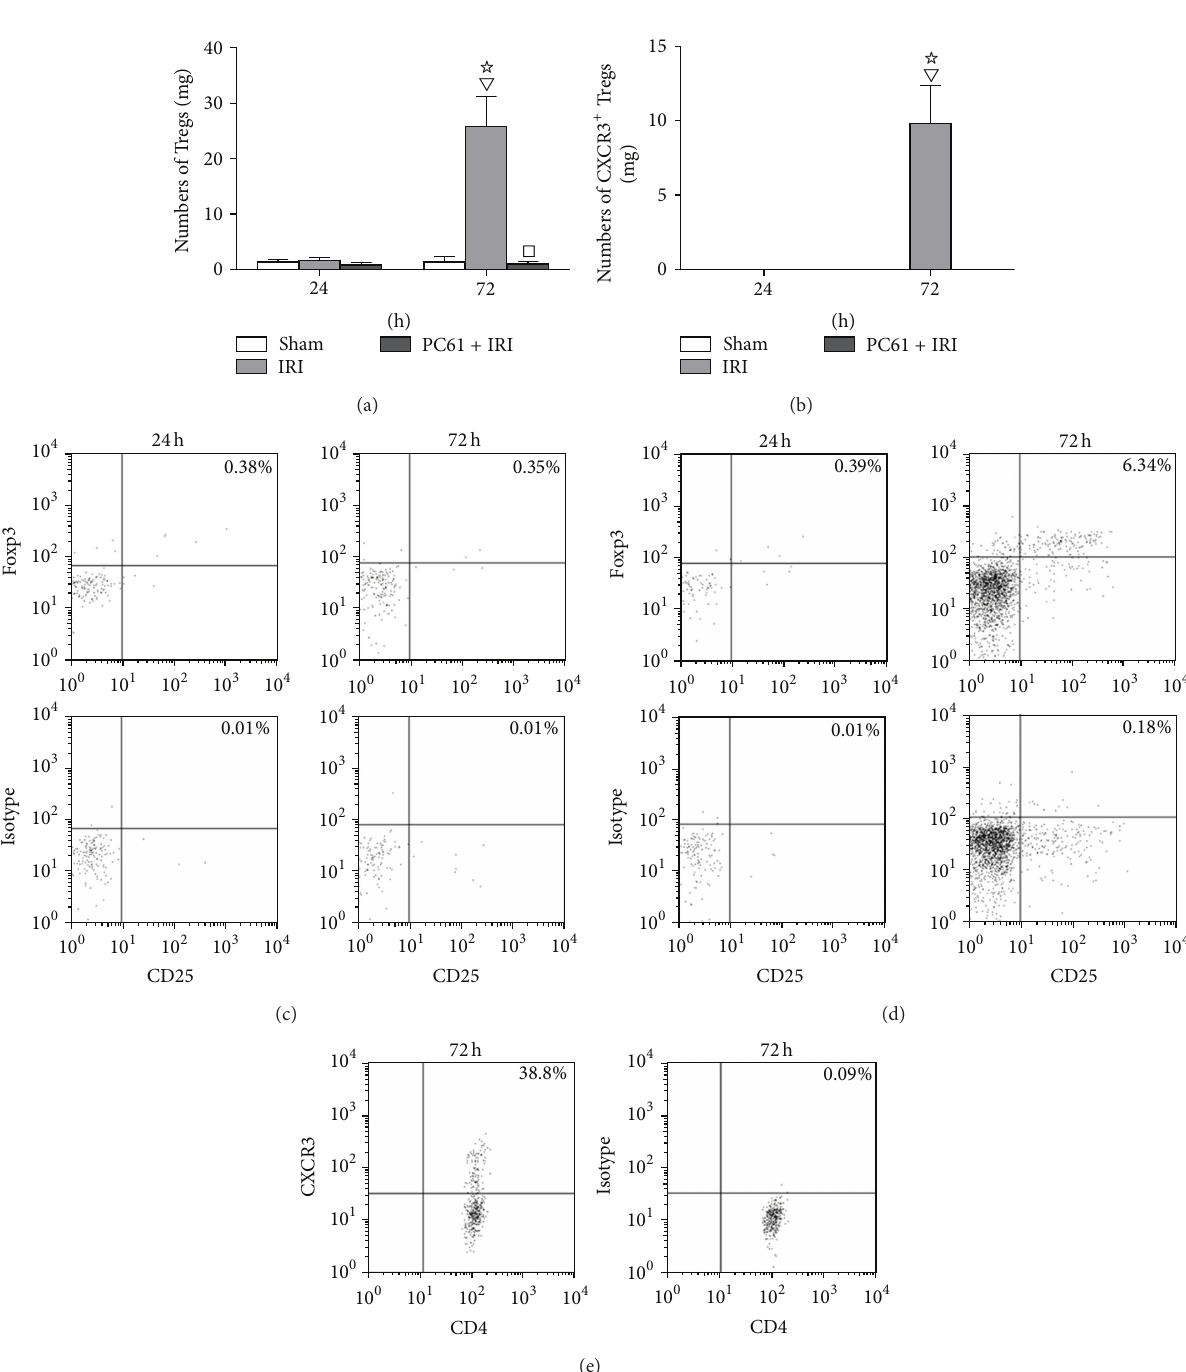
Figure 3: Numbers of Tregs and CXCR3 + Tregs in kidney at 24 h and 72 h after reperfusion measured by flow cytometry analysis. (a) Numbers of CD4 + CD25 + Foxp3 + Tregs in kidney at 24 h and 72 h after reperfusion. (b) Numbers of CXCR3 + CD4 + CD25 + Foxp3 + Tregs in kidney at 24 h and 72 h after reperfusion. Values of the bar graphs represent the mean ± SD ( 𝑛 = 8 per group). Compared with the Sham group, 󳶚 𝑃 < 0.05 ; compared with the IRI group at 24 h after reperfusion, f 𝑃 < 0.05 ; compared with the IRI group at 24 h or 72h after reperfusion, ◻ 𝑃 < 0.05 . (c) Representative dot plots of Tregs in kidney from Sham group at 24 h and 72 h after reperfusion. (d) Representative dot plots of Tregs in kidney from IRI group at 24 h and 72 h after reperfusion. The CD4 + T cells were initially gated from the lymphocyte area by forward scatter (FSC) versus side scatter (SSC), and then the expression of CD25 and Foxp3 was analyzed in this population. The percentage of CD4 + CD25 + Foxp3 + Tregs in CD4 + cells was obtained in the upper right quadrant. (e) Representative dot plots of CXCR3 + Tregs from the IRI group. Because there were no CXCR3 + Tregs detected in the kidney from the Sham or IRI group at 24 h after IRI, only dot plots from the IRI group at 72 h after reperfusion were shown. The percentage of CXCR3 in the CD4 + CD25 + Foxp3 + population was shown in the upper right